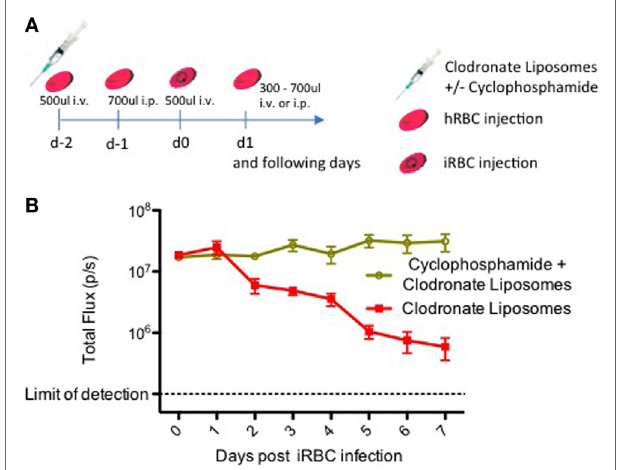
FIGURe 1 | Immune modulation with clodronate liposomes and cyclophosphamide leads to a stable Plasmodium falciparum blood stage infection. (A) Timeline showing the protocol for the repopulation of liver-humanized FRGN KO mice with human red blood cells (hRBCs) and subsequent infection with blood stage parasites. This protocol was utilized here to assess the effect of cyclophosphamide on a P. falciparum blood stage infection in FRGN huHep mice. Six mice received an injection of 50 µl CloLip i.v. + 50 µl CloLip i.p. on day − 2 and three mice additionally